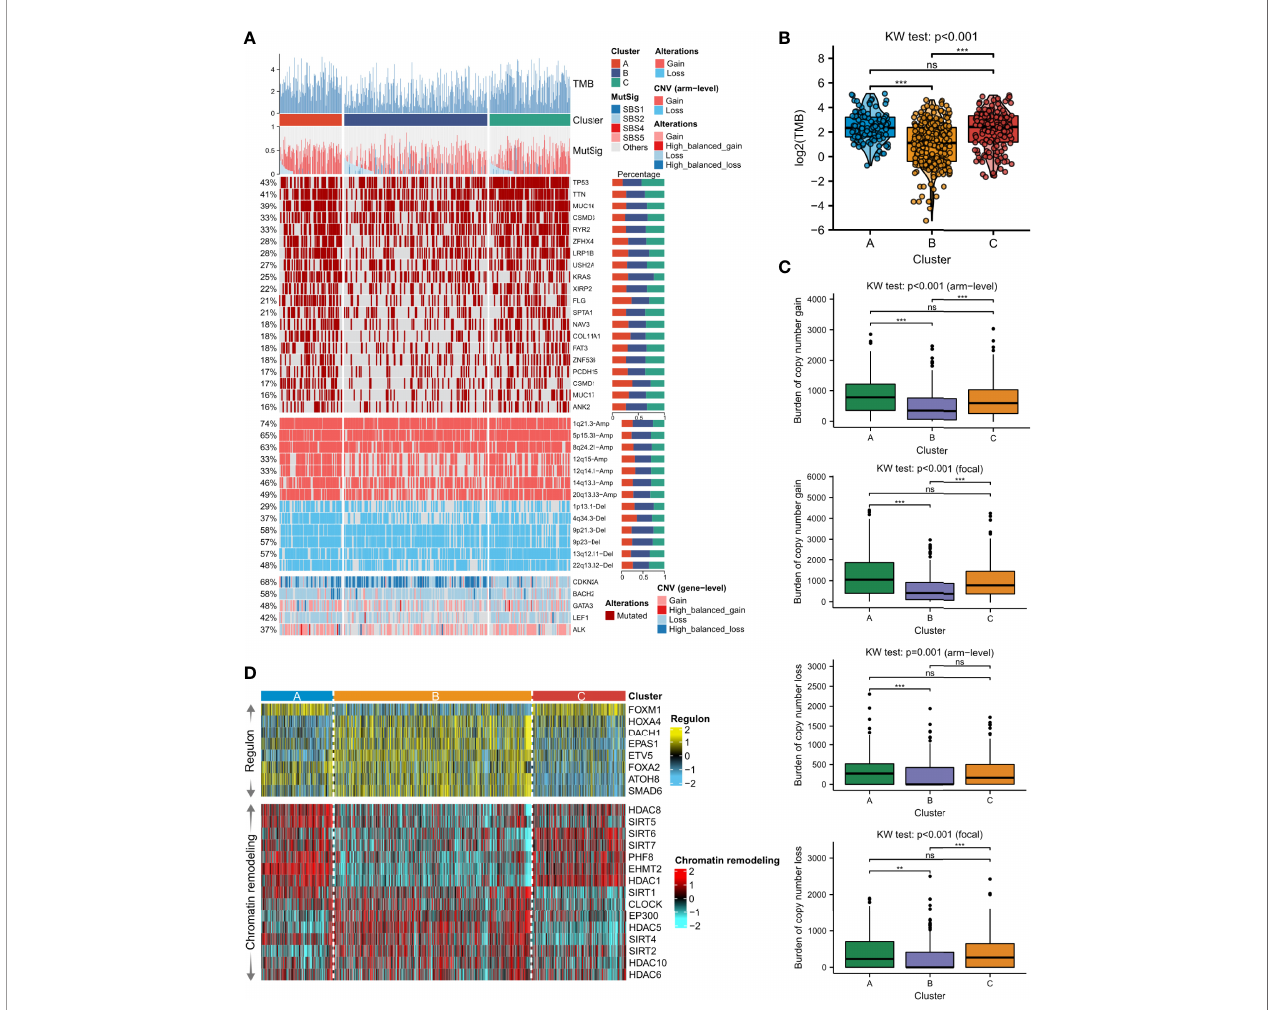
FIGURE 4 | Distinction of the genomic features among the three necroptosis phenotypes. (A) Somatic mutation landscape according to necroptosis clustering subtypes. Tumor mutation burden (TMB), the relative contribution of the four mutational signatures (SBS1, SBS2, SBS4, and SBS5), selected top-mutated genes, and top-broad-level copy number alterations (q-value<0.05), and selected necroptosis molecules were shown from the top to the bottom panels. The proportion of variation conversions was presented in the right stacked bar plots. (B) TMB differences among the three clusters were revealed by Kruskal-Wallis test. (C) Focal and arm-level copy number variations among the necroptosis phenotypes were revealed by Kruskal-Wallis test. Asterisks denoted p-value (***p<0.001, **p<0.01 and ns was the abbreviation of no signi fi cance). (D) The heatmap showed regulon activity pro fi les for eight transcription factors (upper panel) and potential regulators associated with chromatin remodeling (bottom